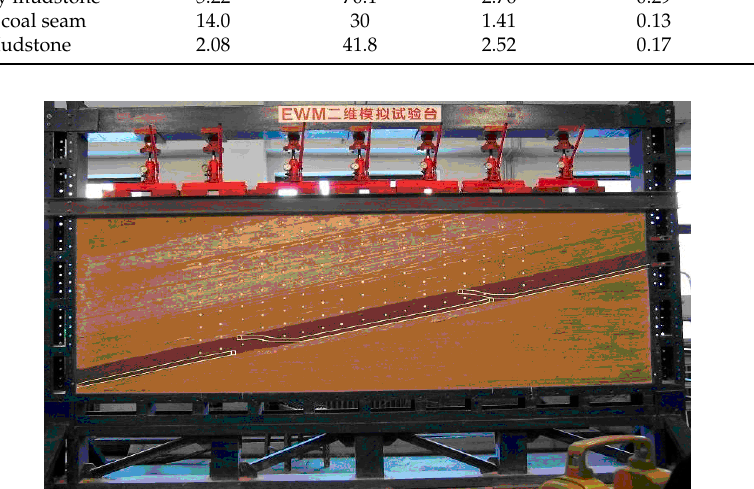
Figure 11. Physical model.